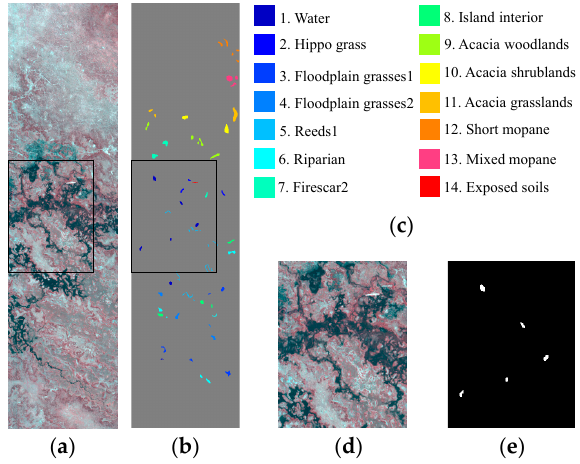
Figure 14. ( a ) The false color sense of the Okavango Delta data (bands 46, 18, 15). ( b ) The groundtruth of different categories. ( c ) The legend of different categories. ( d ) A subset of ( a ), used in the experiment. ( e ) Groundtruth of water in ( d ).